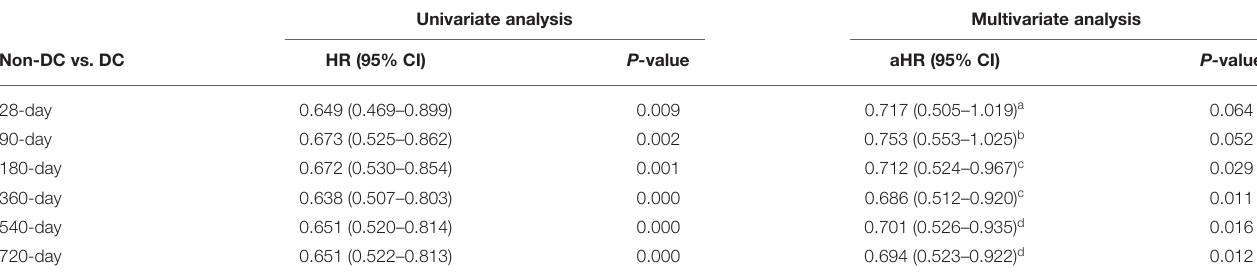
TABLE 3 | Adjusted HRs and 95% CI of decompensated cirrhosis (DC) for acute-on-chronic liver failure (ACLF) mortality by Cox proportional hazards model. Univariate analysis Multivariate analysis Non-DC vs.